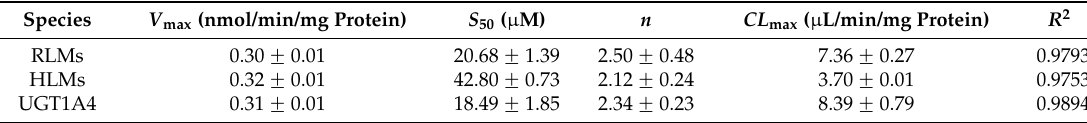
Figure 3. Enzyme kinetics of PPD glucuronidation by rat liver microsomes (RLMs) ( A ); human liver microsomes (HLMs) ( B ) and recombinant UGT1A4 ( C ). PPD (10–500 μ M) was incubated with HLMs and RLMs (0.5 mg protein/mL) in the presence of UDPGA. An Eadie–Hofstee plot is shown as an inset. Data were obtained from three replicates. Table 2. Kinetic parameters for the formation of PPDG with pooled human liver microsomes (HLMs), rat liver microsomes (RLMs), and recombinant human UGT1A4 (Enzyme kinetic parameters were determined by Hill kinetics at 10–500 µ M PPD. Data were expressed as mean ˘